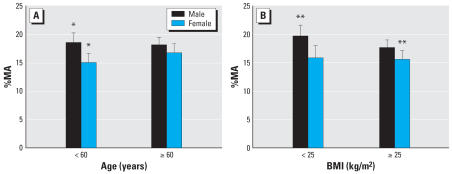
The mean and confidence interval of %MA by age (A) and BMI (B) in males and females.*p = 0.03.**p = 0.04.